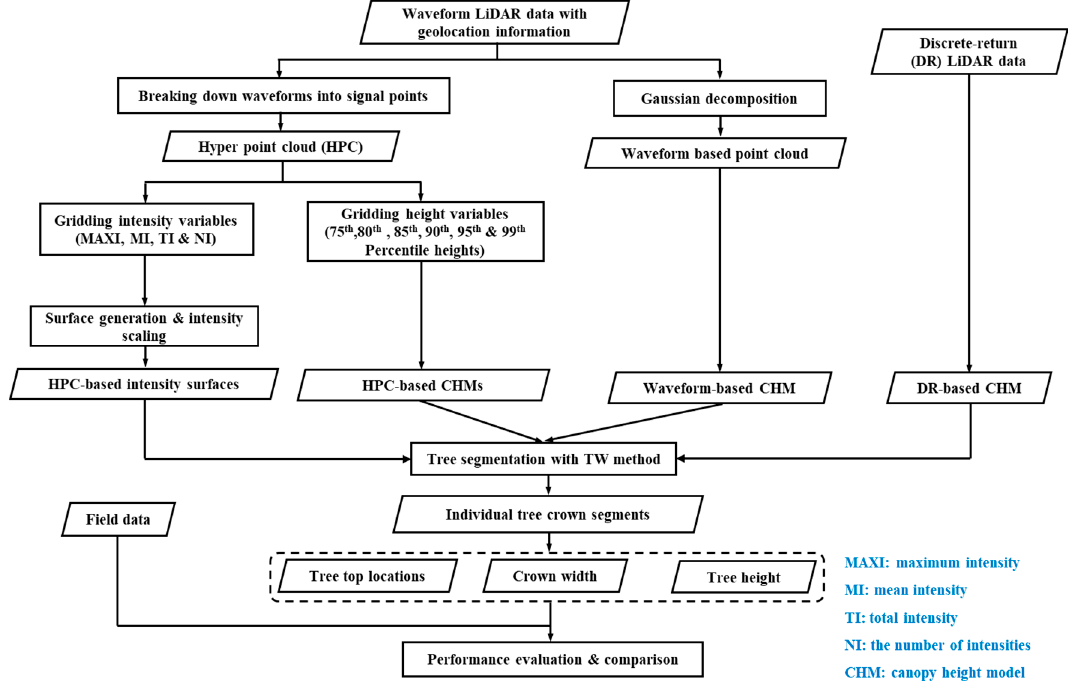
Figure 2. The flowchart of utilizing the hyper point cloud to extract tree attributes.